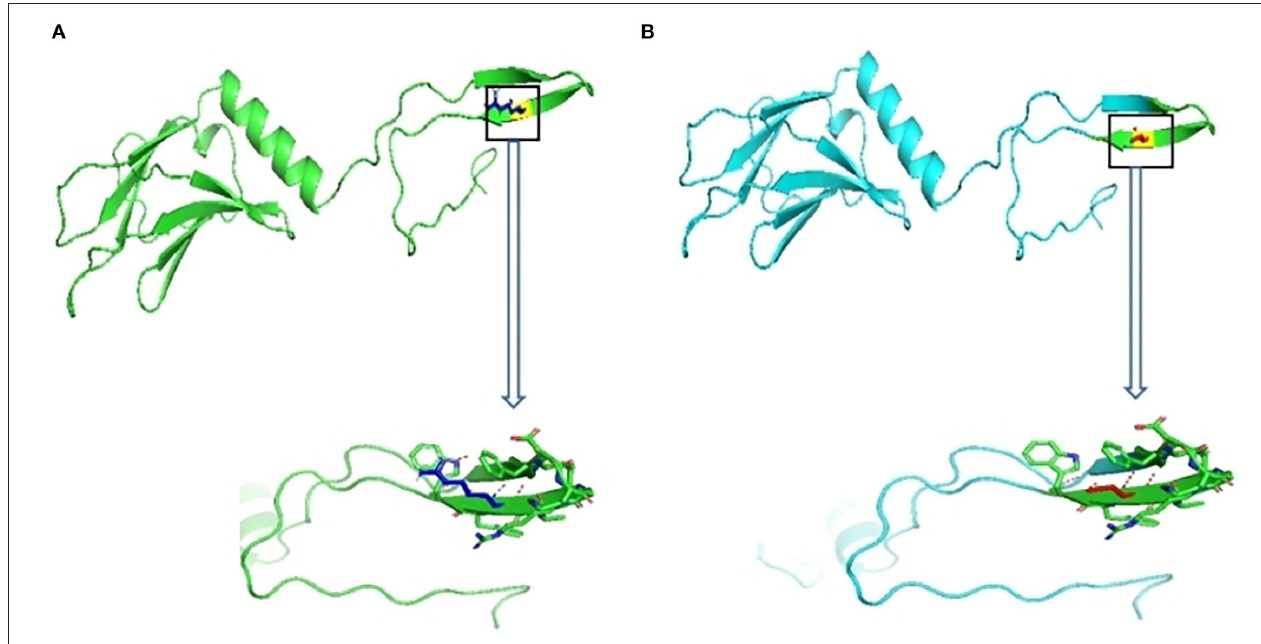
FIGURE 4 | Wild-type and variant structure of MYOM2 protein. (A) Wild-type MYOM2 predicted 3D structure. (B) Mutation MYOM2 predicted 3D structure. Supplemental Figure 1 Echo images from the twins’ father. The above 4 figures were taken from Cardiac ultrasound results. These figures illustrate the shape, structure, wall thickness, and function of the heart were all